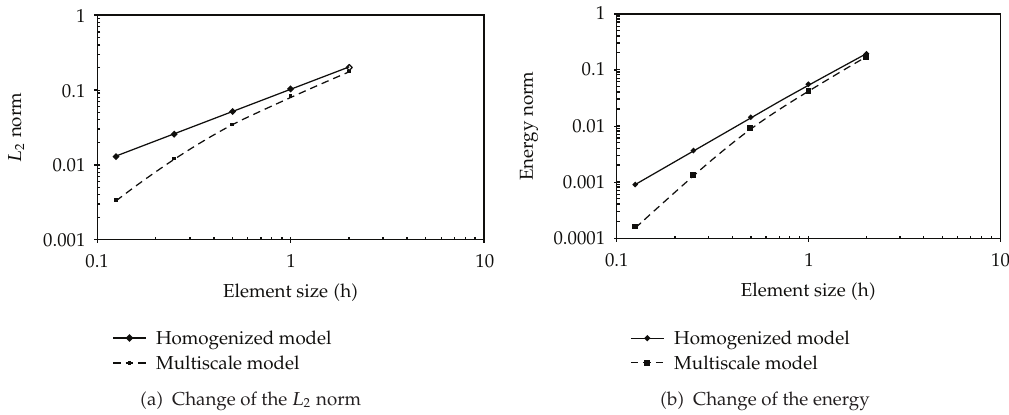
Figure 9: Performance of the proposed multiscale method in terms of error in the energy and displacement norm for a cantilever